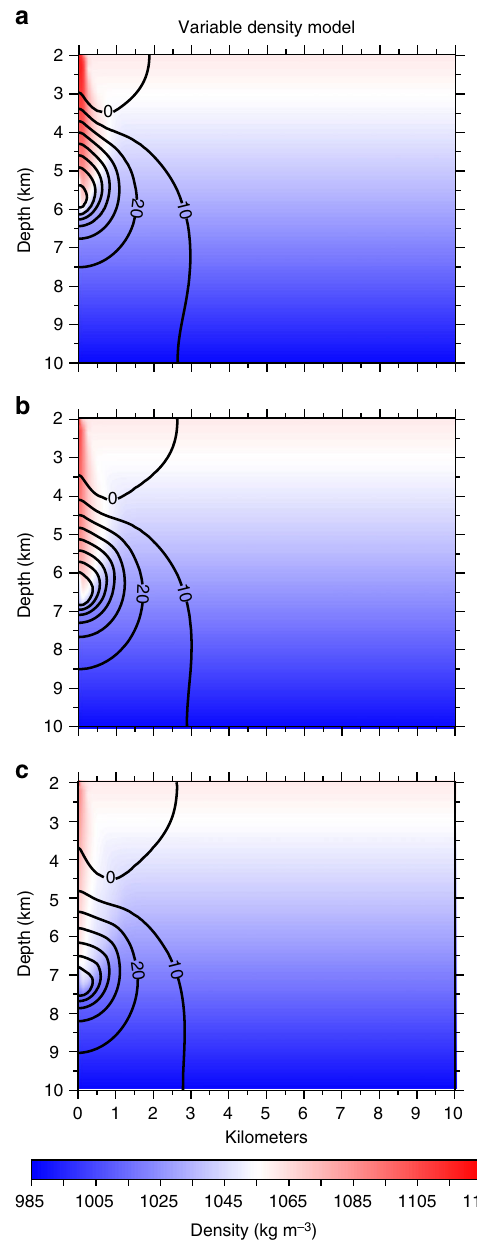
Fig. 4 Post-injection fl uid pressure recovery. Simulation results showing post-injection fl uid pressure patterns for the variable density